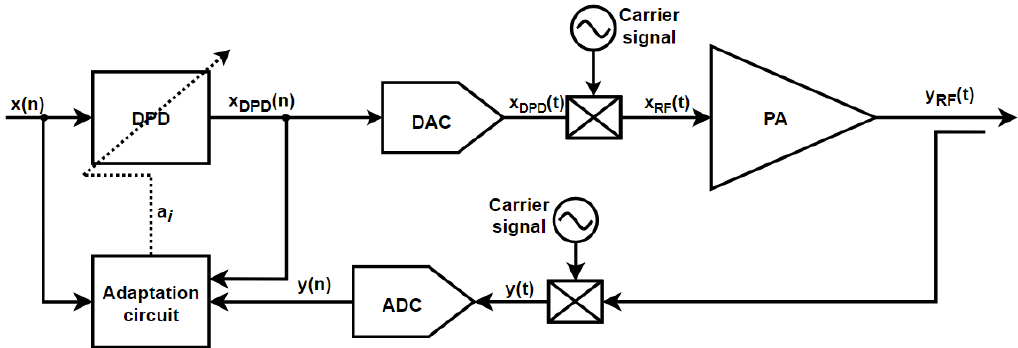
Figure 9. Adaptive predistortion operational diagram.